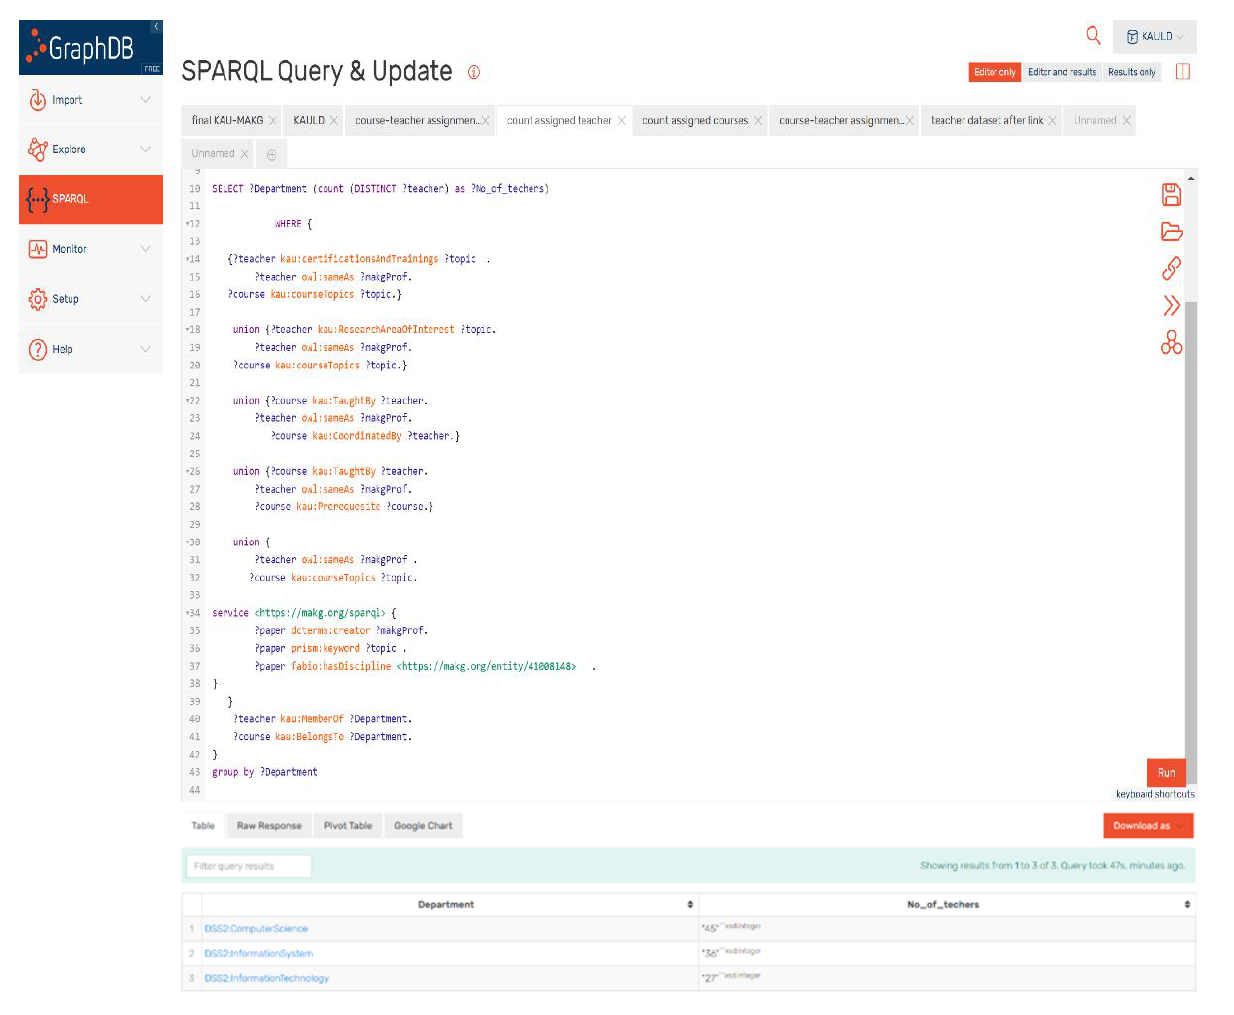
Figure 17. Number of allocated teachers using LD.